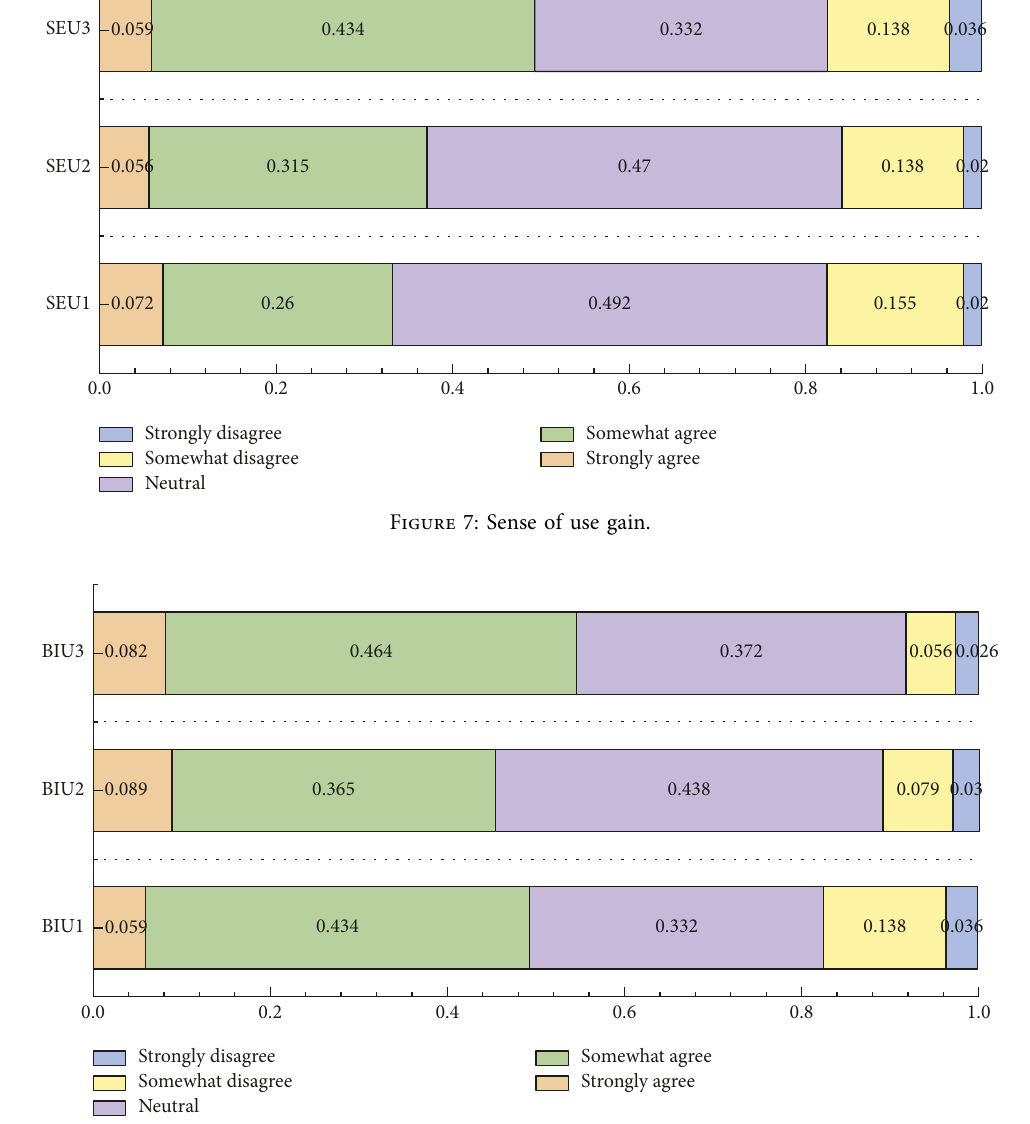
Figure 8: Behavioral intention.